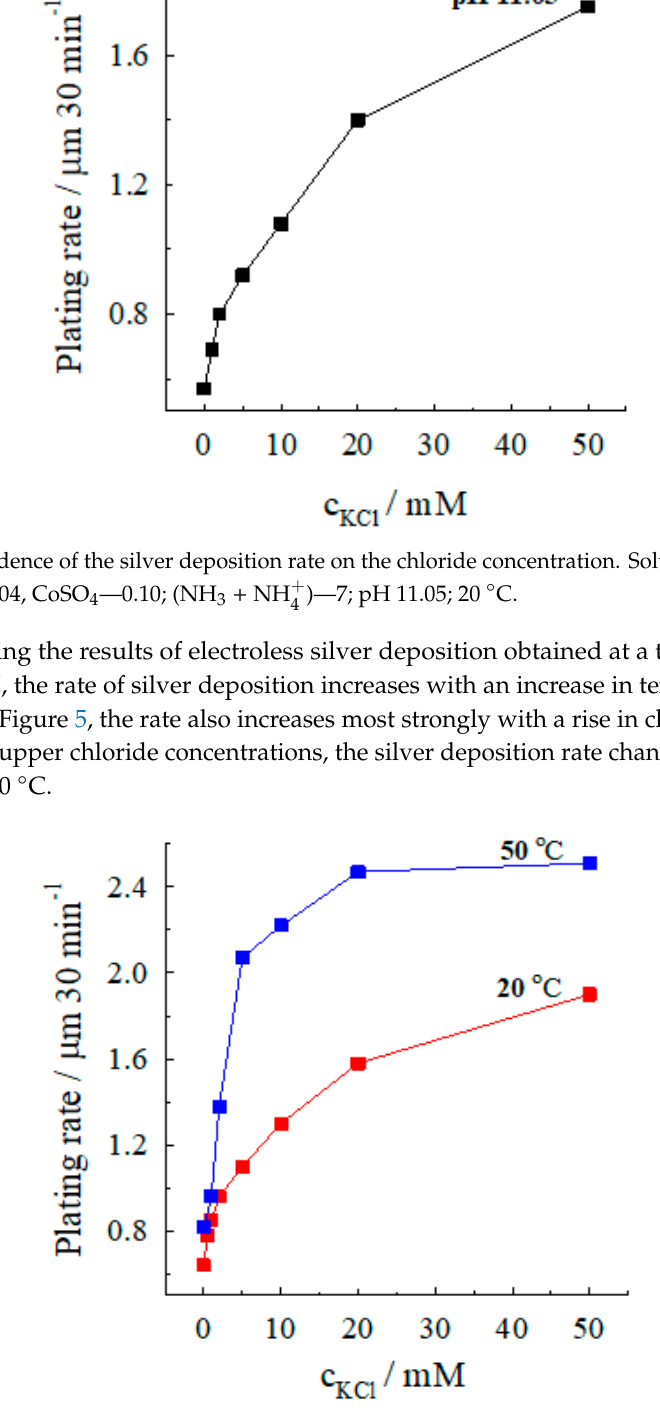
Figure 5. Dependence of the silver deposition rate on chloride concentration at various temperatures. Solution composition (M): AgNO 3 —0.04, CoSO 4 —0.10; (NH 3 + NH 4+ )—4; pH 10.2.